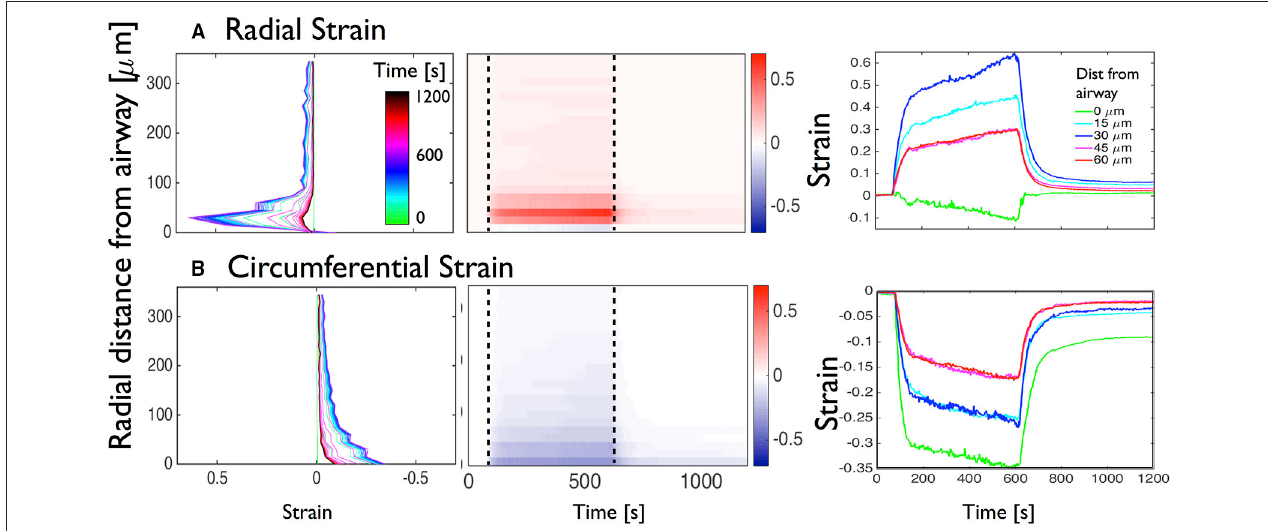
FIGURE 5 | Global analysis of the deformations of the mouse lung slice in Figure 1. Temporal evolution of (A) radial and (B) circumferential strains as a function of distance from the airway. Left column: superimposition of distance-strain line plots for increasing time as indicated by the colorbar (inset on top figure of left column). Middle column: adapted kymographs showing magnitude of strain, as indicated by the colorbar to the right of each figure. Right column: superimposition of line plots showing temporal evolution of strain at 0, 15, 30, 45, and 60 µ m from the airway lumen.